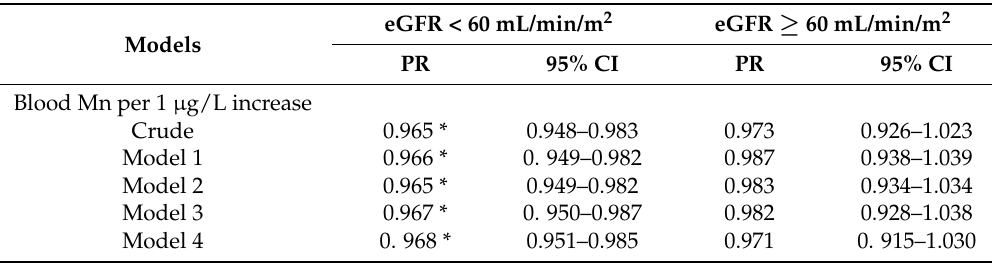
Table 4. Poisson regression analysis with robust variance for anemia in subgroups according to renal